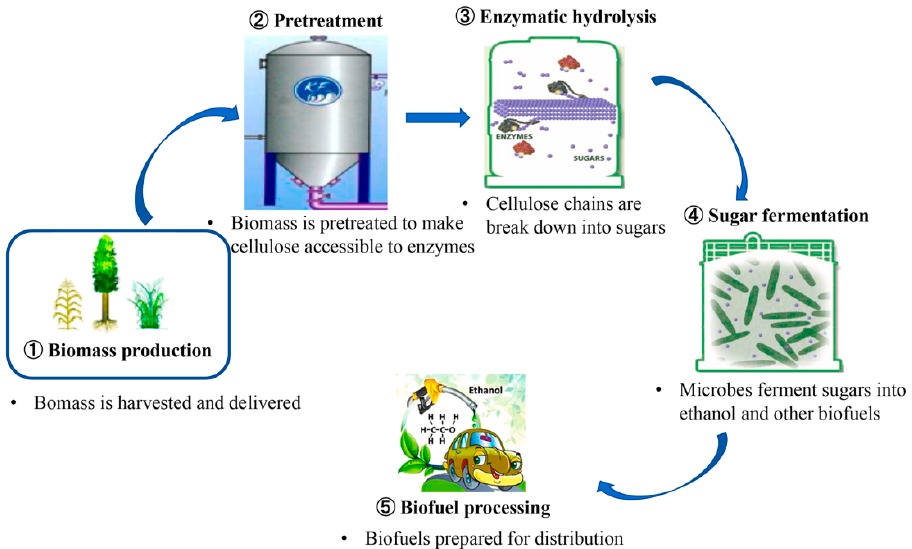
Figure 1. Bioconversion of lignocellulosic biomass to biofuel via feedstock production, biomass pretreatment, enzymatic hydrolysis, sugar fermentation, and biofuel processing [15].